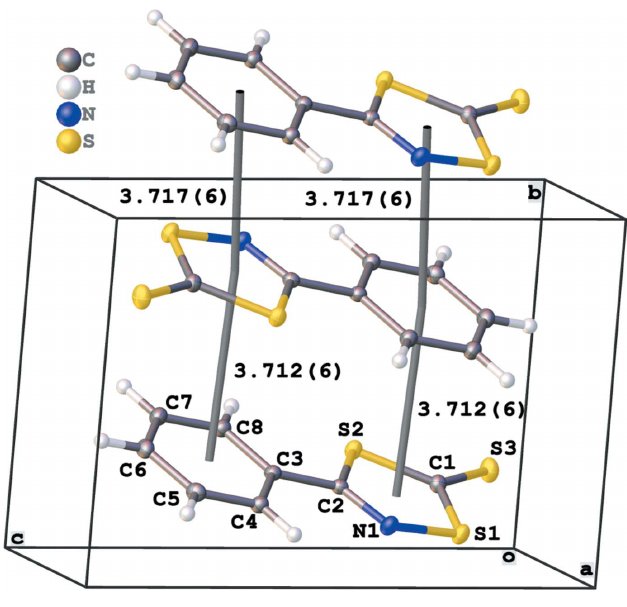
Figure 2 Packing diagram illustrating centroid-stacking interactions down the b- axis direction ( a ) between parallel-aligned ring systems with co-planar molecules flipped across an inversion centre [centroid-to-centroid distance = 3.712 (6) A˚ ] and packed back to back [centroid-to-centroid distance = 3.717 (6) A˚ ]. The three molecules are staggered with an angle of 166.698 (17) (cid:2) and two molecules fit within the the P 1 unit